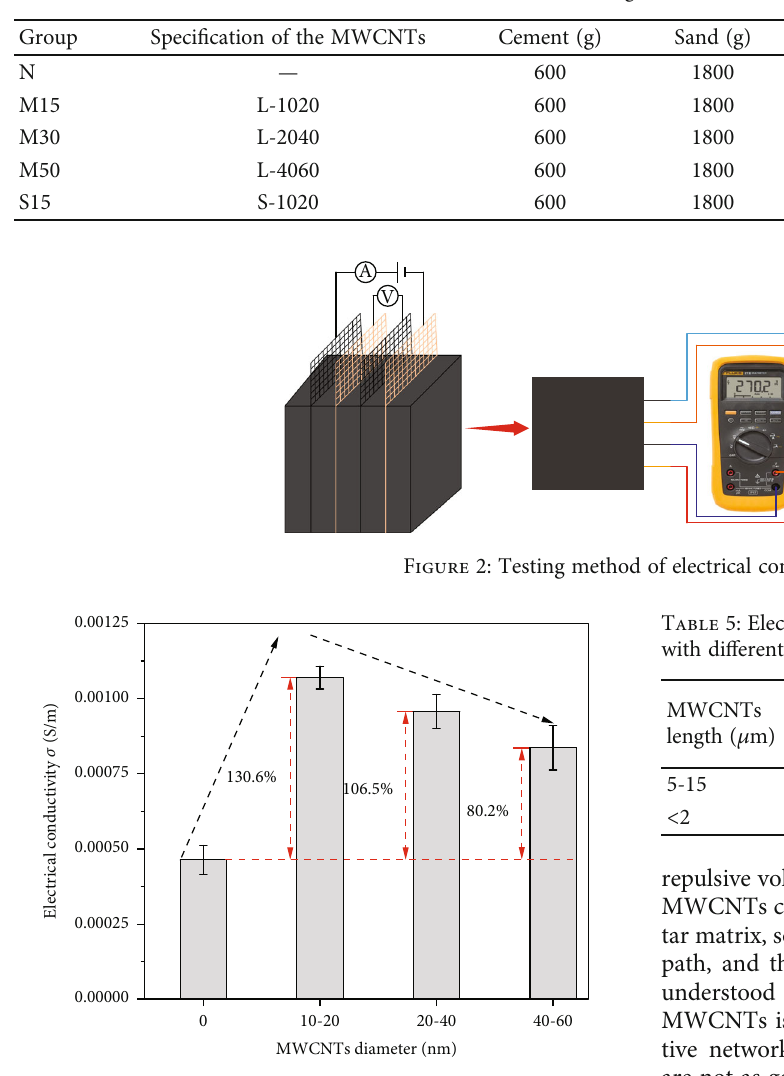
Figure 3: Relationship between electrical conductivity of MWCNTs/CM and MWCNTs diameter.